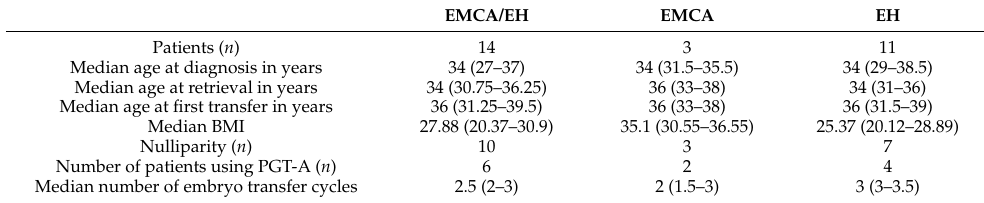
Table 1. Baseline demographics of patients with EMCA/EH after FST presenting for embryo transfer. EMCA/EH EMCA EH Patients ( n